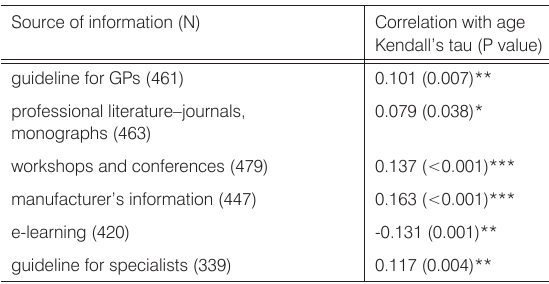
Figure 1. Use of information sources about osteoporosis among 525 general practitioners in Table 2. Correlations between use of information sources and age among 525 general practitioners in CZ (N values represent numbers of respondents with the two non-missing re- sponses used in the calculation).